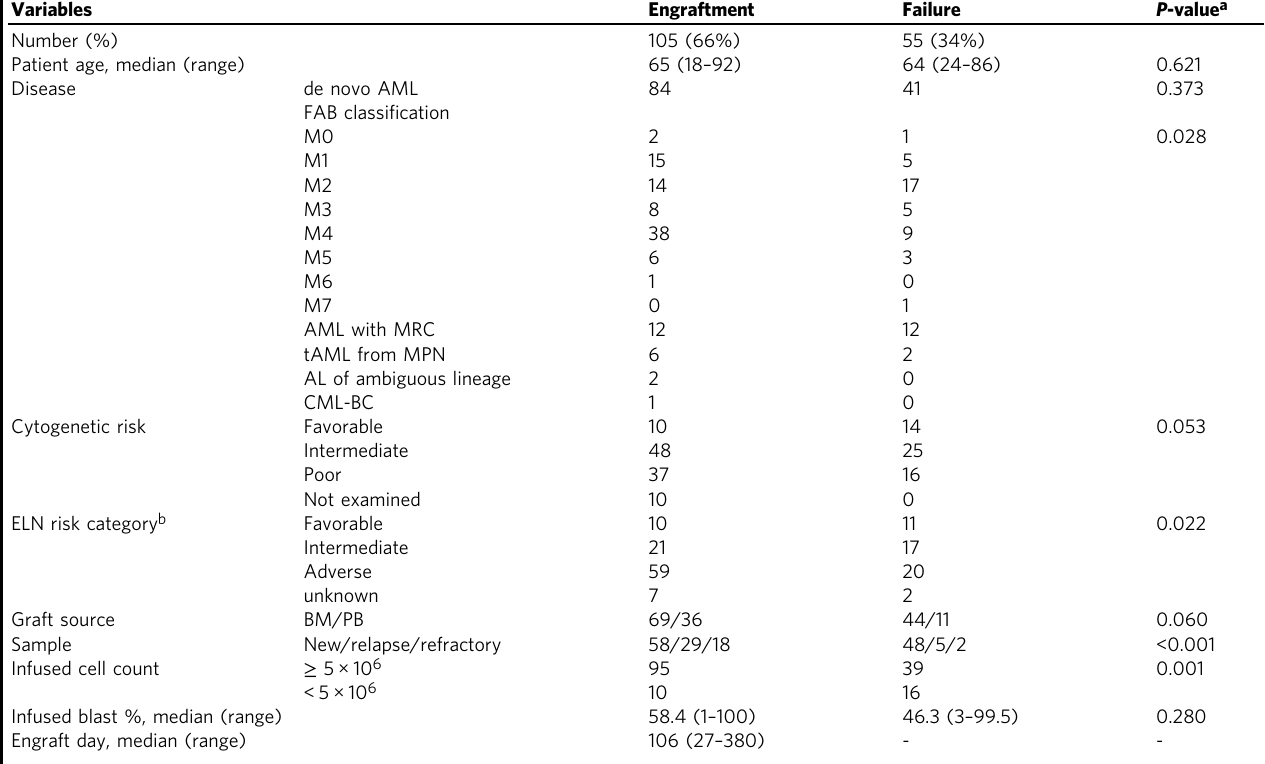
Table 1 Characteristics of patients ’